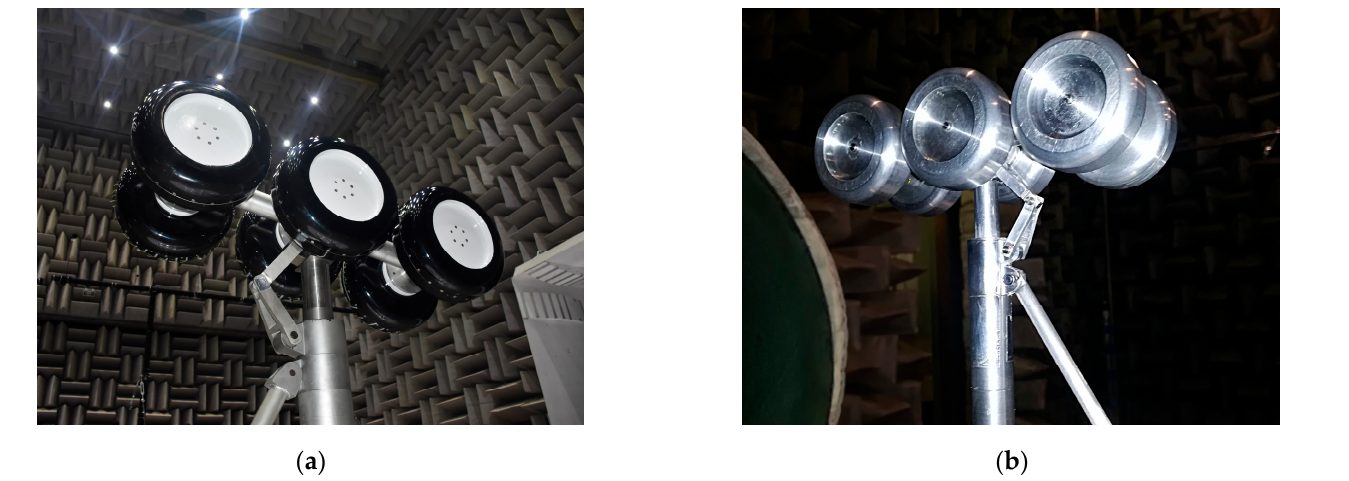
Figure 7. Photos of landing gear models: ( a ) large-scale model in FL-17 CARDC; ( b ) small-scale model in AC-2 TsAGI.